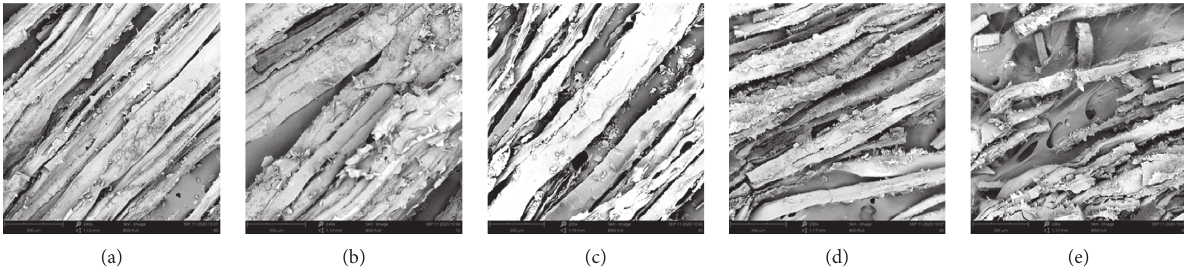
Figure 2: Microstructure observation of GSJs during roasting through scanning electron microscopy (SEM) at a magnification of 230x. (a) 0 min. (b) 20 min. (c) 40min. (d) 60min. (e) 80min.